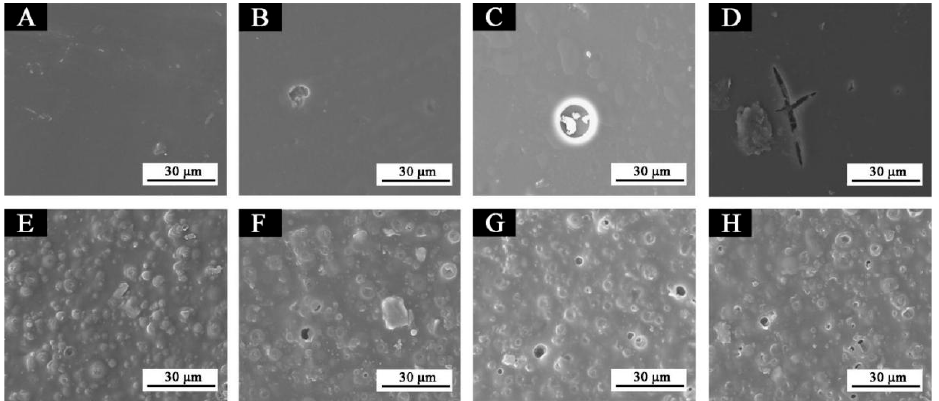
Figure 8. SEM images of sample 5# and sample 8# coatings before and after aging in different aging environments: ( A ) sample 5# before aging, ( B ) 120 °C [22], ( C ) 160 °C, ( D ) UV, ( E ) sample 8# before environments: ( A ) sample 5# before aging, ( B ) 120 ◦ C [22], ( C ) 160 ◦ C, ( D ) UV, ( E ) sample 8# before aging, ( F ) 120 °C, ( G ) 160 °C, ( H ) UV. aging, ( F ) 120 ◦ C, ( G ) 160 ◦ C, ( H )